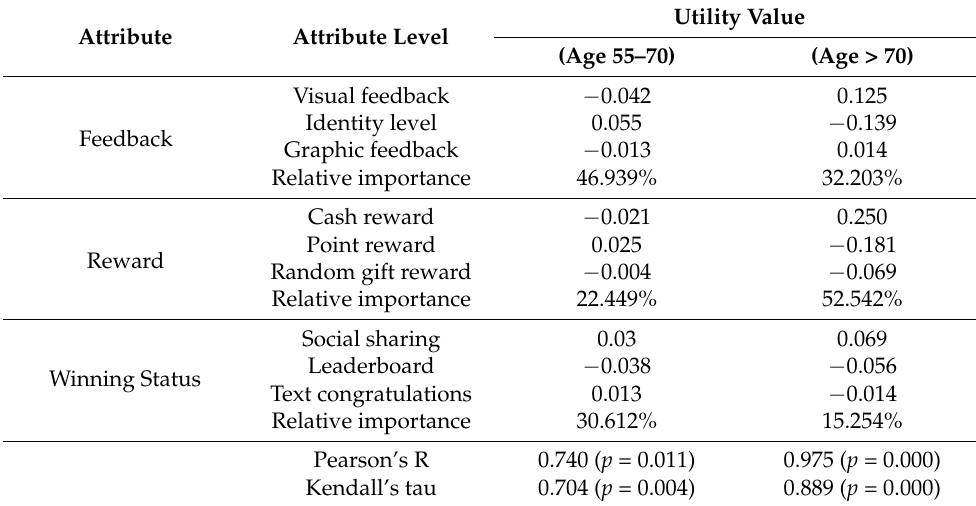
Table 7. Utility value of attribute levels classified by age.